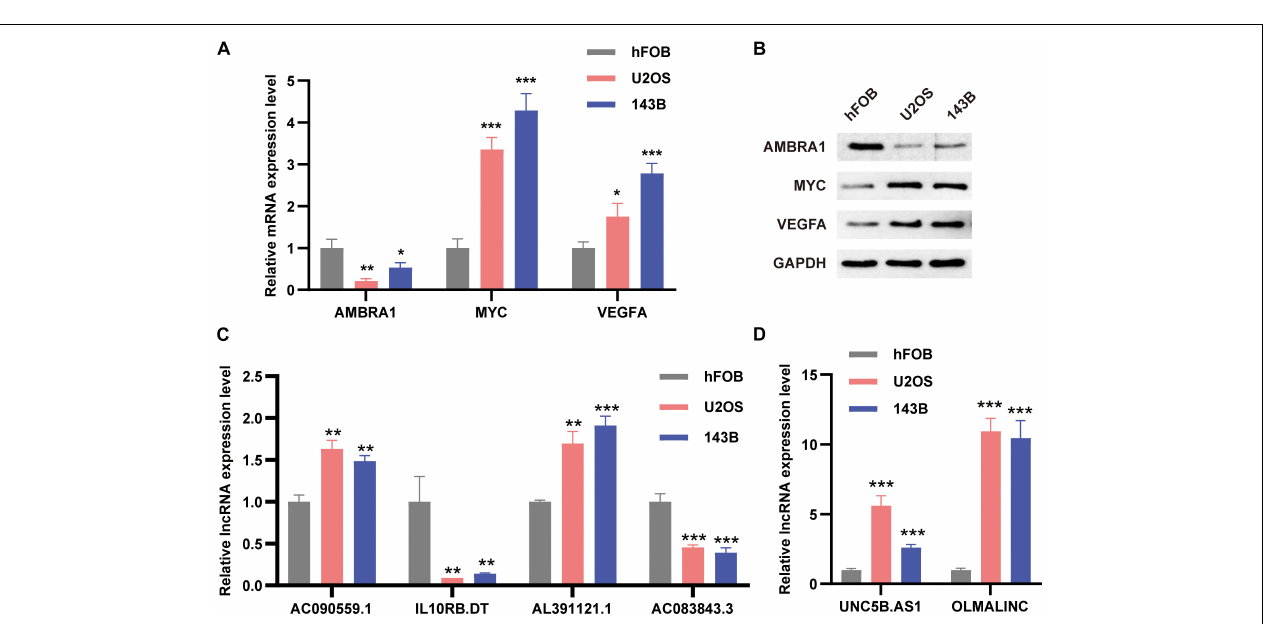
FIGURE 9 | The correlation analysis of prognostic autophagy-associated biomarkers. (A) The x -axis and y -axis represent genes. Red blocks represent positive correlation, and blue blocks represent negative correlation. And shade of color represents Pearson correlation index R. (B) Correlation between the expression of lncRNA AC090559.1 and MYC gene expression.